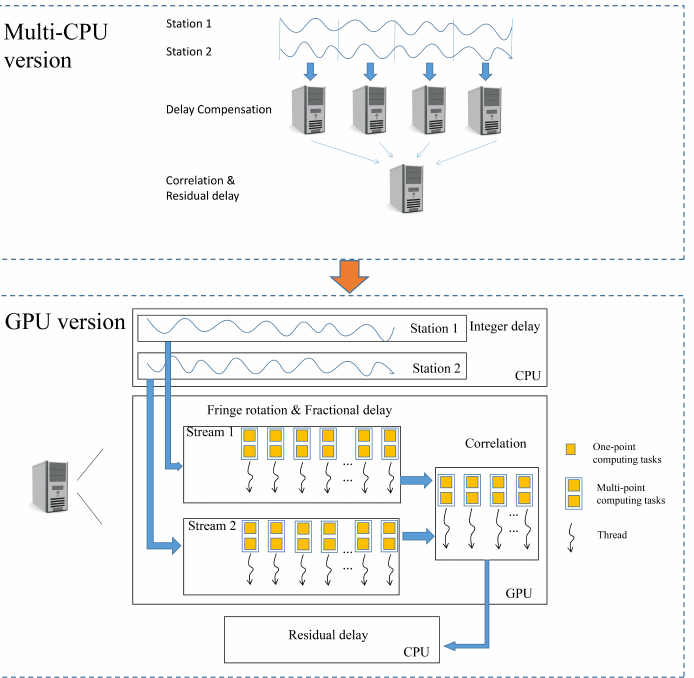
Figure 4. Illustration of parallel VLBI based on multilevel graphics processing unit (GPU)